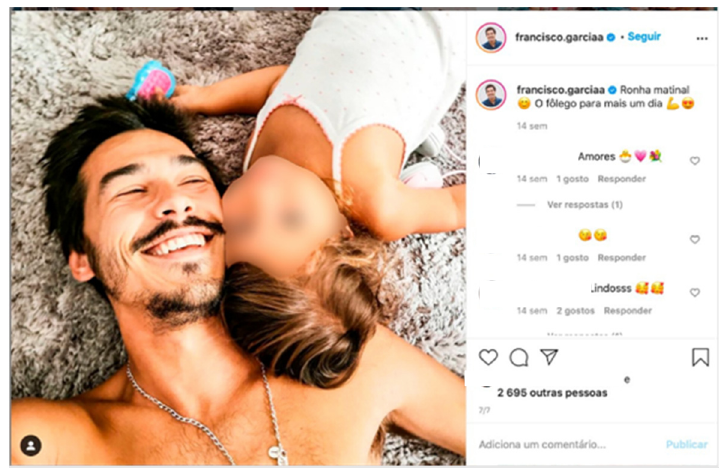
Figure 1. Example of the “Everyday life”; Instagram @francisco.garciaa, Post, 7 July 2020.